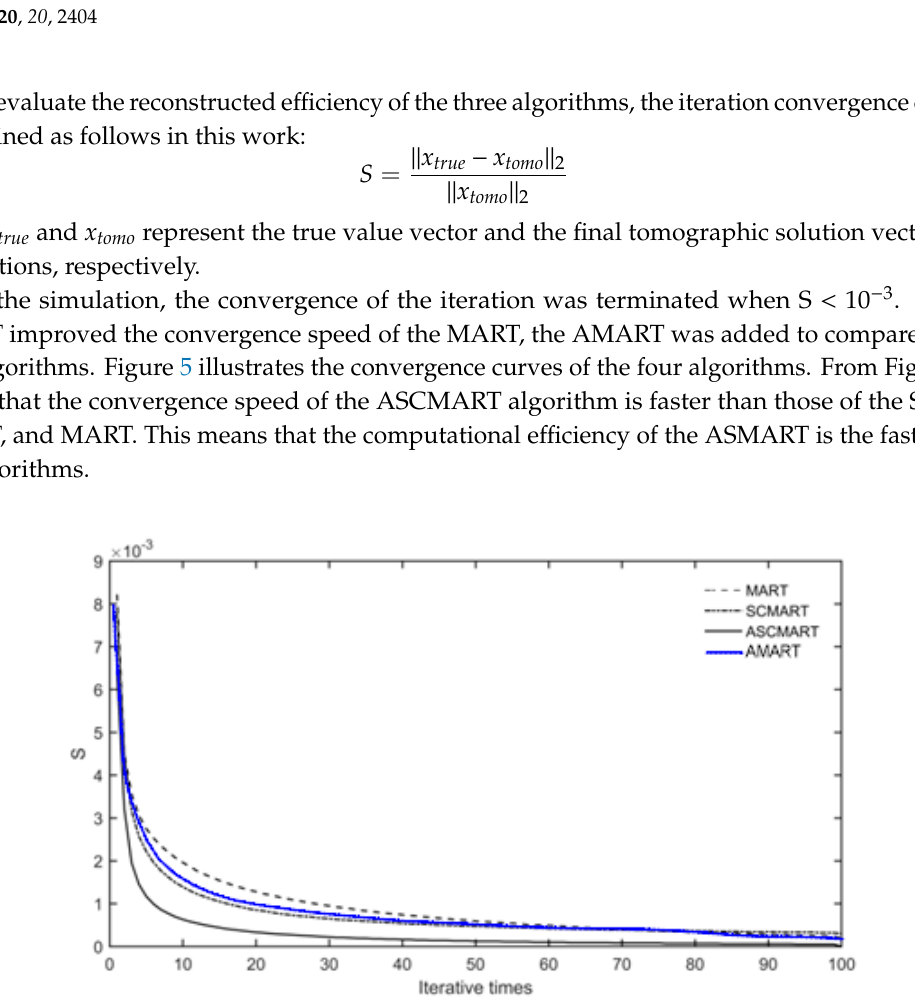
Figure 6 . The variations in (cid:1830)(cid:1871)(cid:1872) index and (cid:1837)(cid:1868) index from June 20 to 24, 2015.